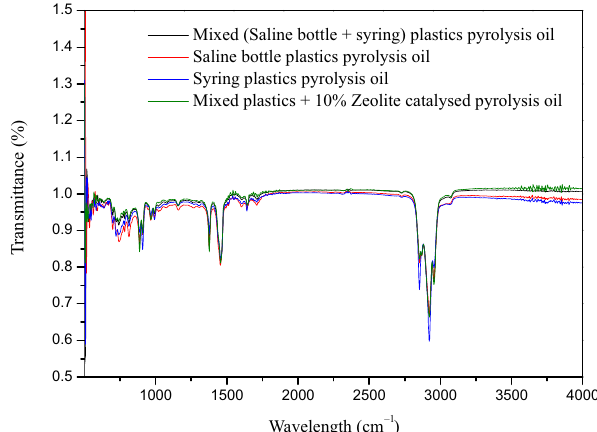
Figure 17. FTIR plot of oil